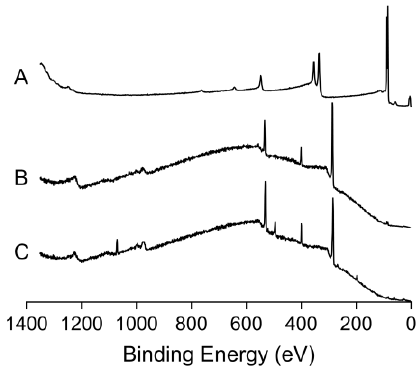
f 0 —Resonant frequency ( f 0 = 10.0 MHz), ∆ f —Frequency change (Hz), ∆ m —Mass change (g), A—Piezoelectrically active crystal area (Area between electrodes, 0.159 cm 2 ), ρ q —Density of quartz ( ρ q = 2.648 g/cm 3 ), µ q —Shear modulus of quartz for AT-cut crystal ( µ q = 2.947 × 10 11 g · cm − 1 · s − 2 ).